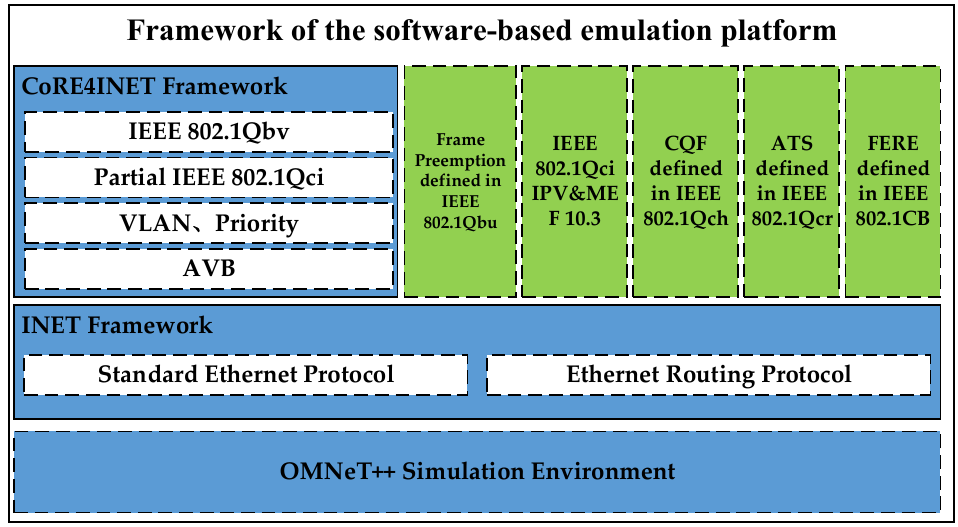
Figure 2. Framework of the software-based emulation platform.